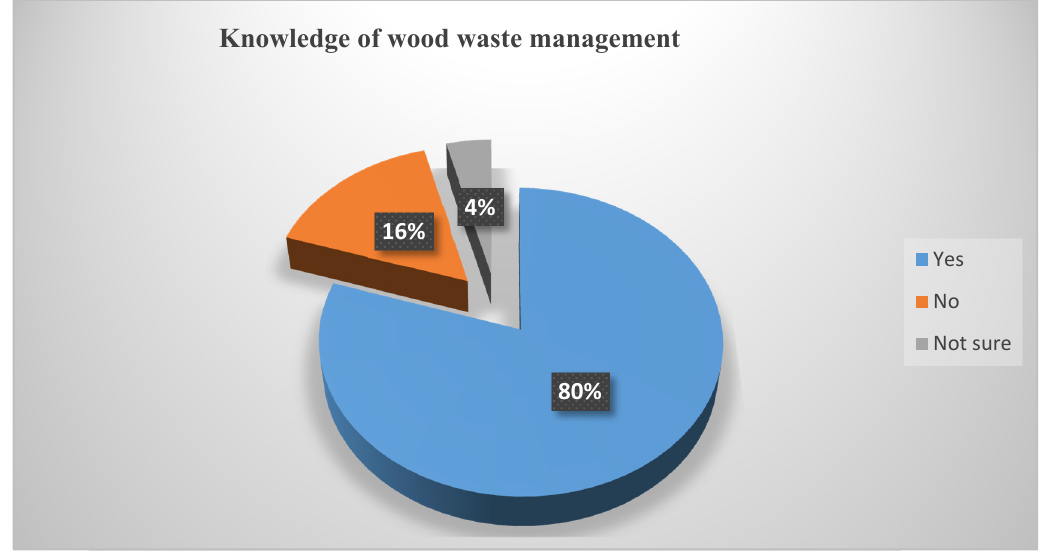
Figure 3. Response to the knowledge of wood waste of timber production companies.